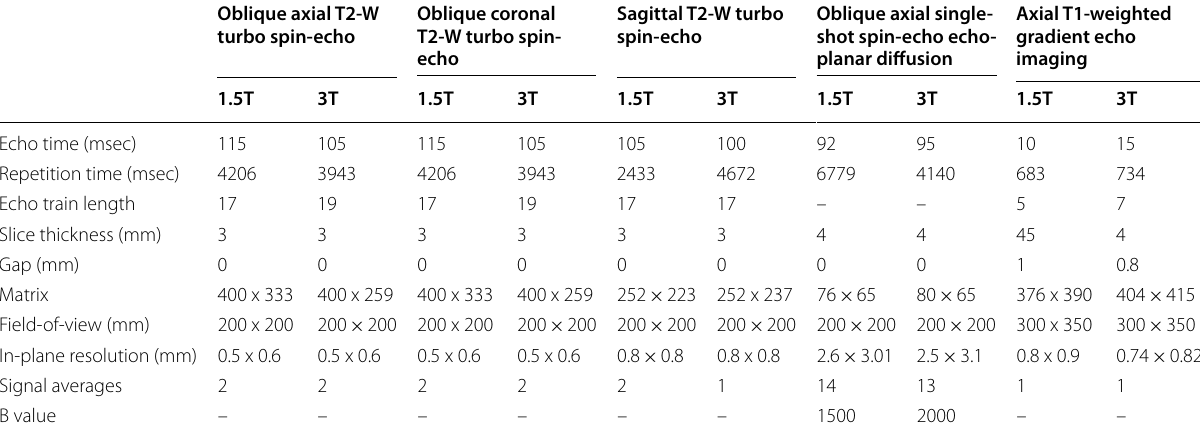
Oblique axial scans are oriented perpendicularly to the long axis of the rectal wall at tumour location; + Spectral pre-saturation with inversion recovery is utilised for fat